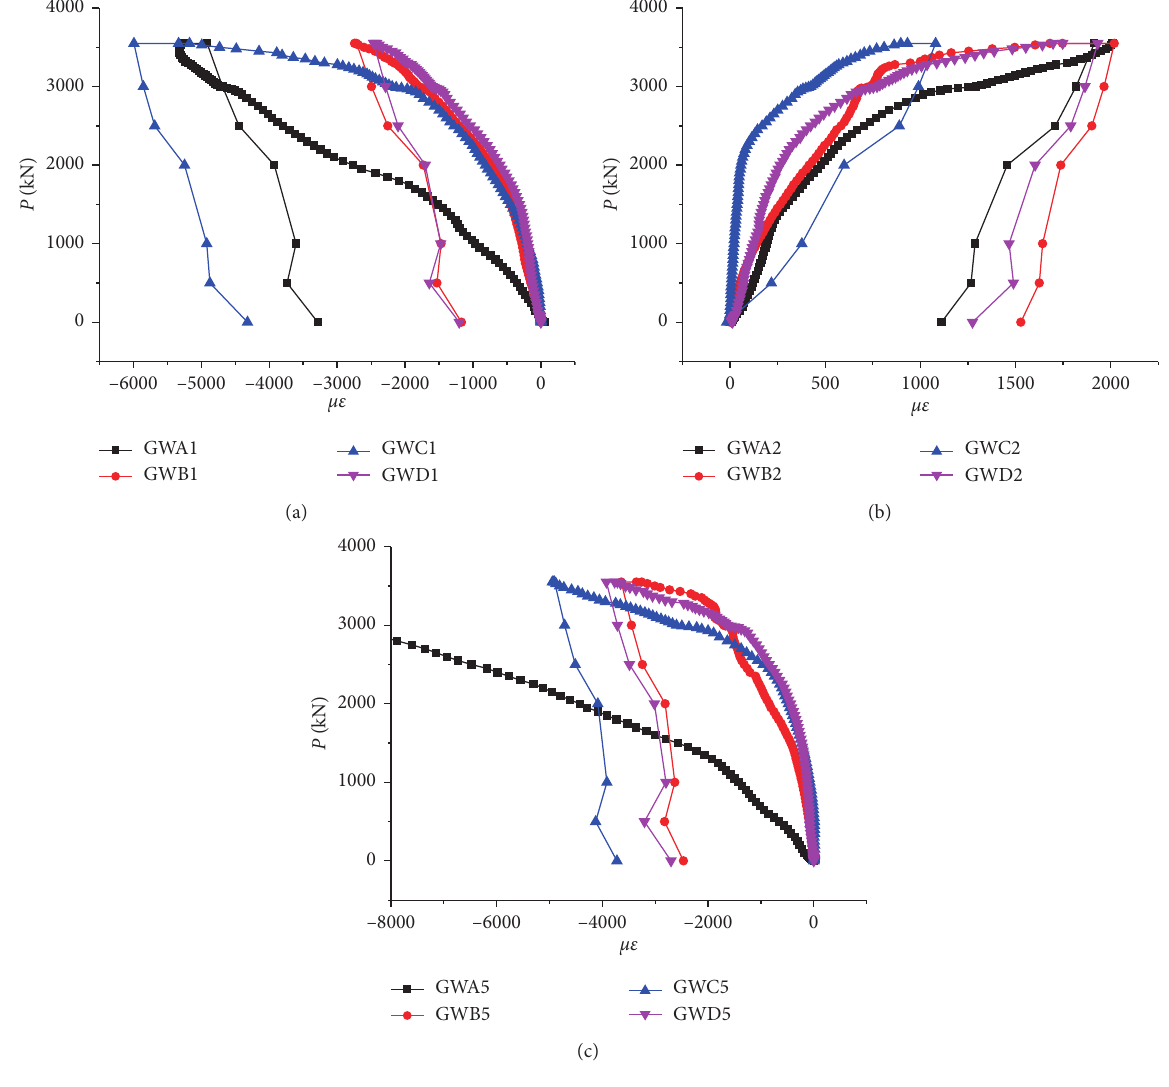
Figure 7: Load-strain curves of the steel tube.